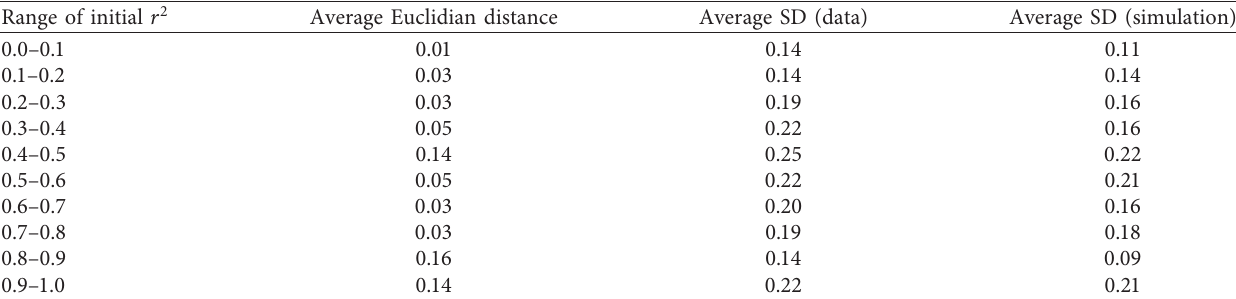
Table 2: Average Euclidean distance between the aggregated simulated and empirical trajectories, tabulated with the standard deviation of both trajectories.